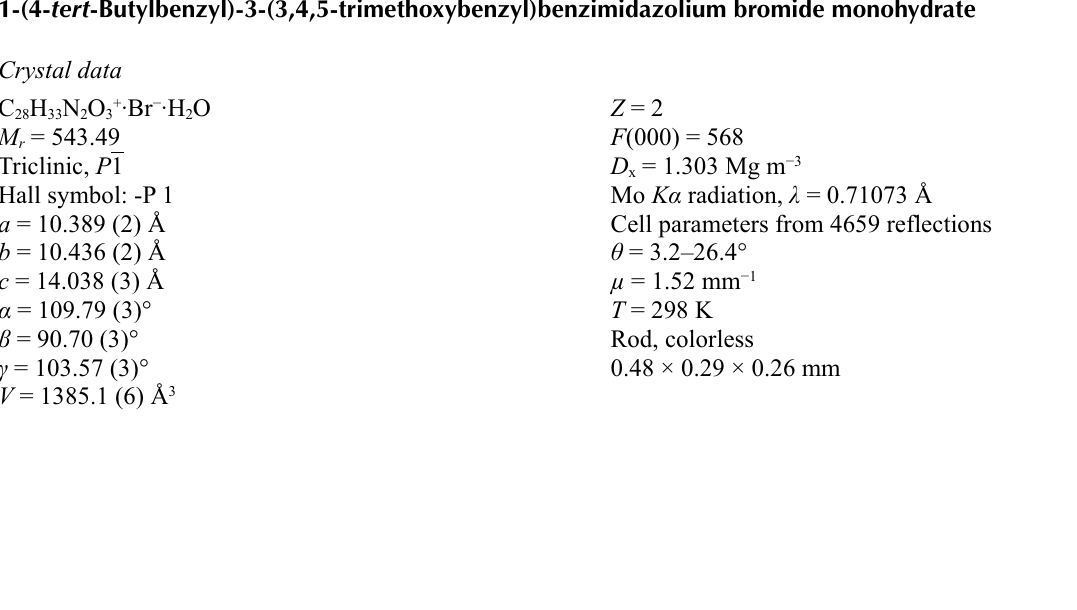
The preparation of the title